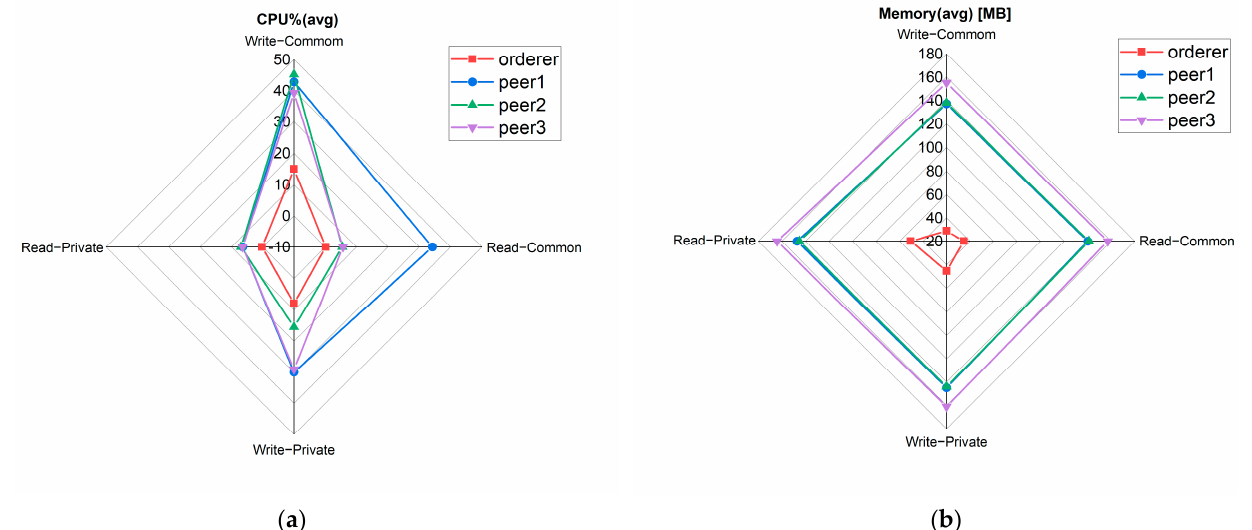
Figure 7. ( a ) The average CPU utilization of the four main nodes to write and read records in the common transaction and private transaction. ( b ) The average memory utilization of the four main nodes to write and read records in the common transaction and private transaction.